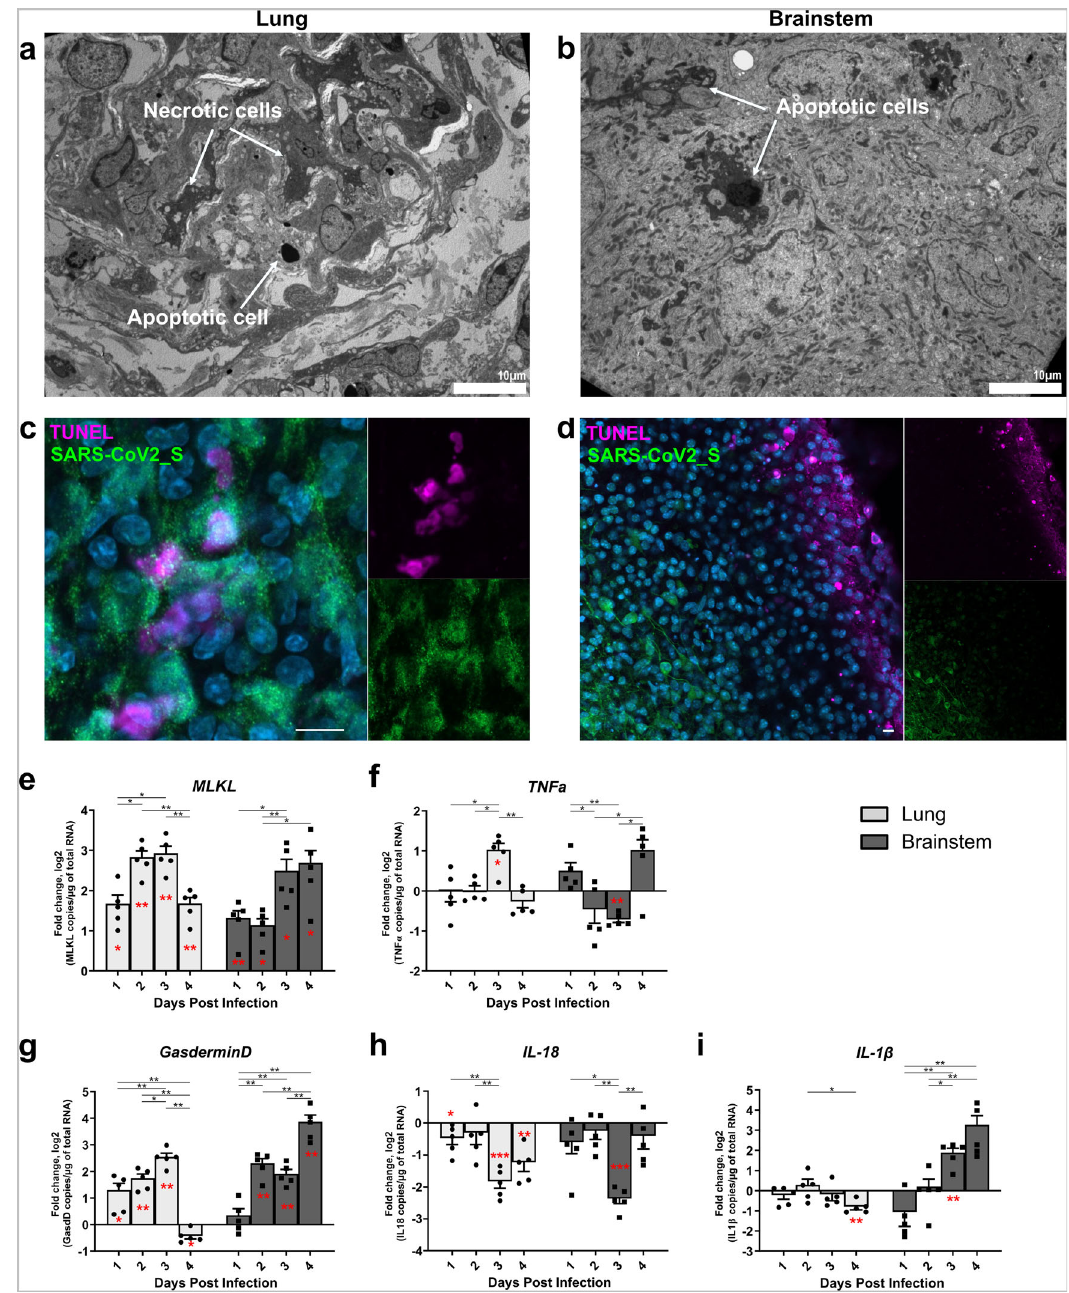
Fig. 6 Cell death in the ex vivo cultures. Hamster ex vivo cultures were infected with 1000 pfu of SARS-CoV-2 ( n = 5 biologically independent animals). a – c Lung and brainstem slices were fi xed at 1 day post infection (dpi) or 2 dpi, respectively. a , b Transmission electron microscopy analysis showing necrotic cells and apoptotic cells, scale bar is represented bottom right on each picture. c , d SARS-CoV-2_S protein immunostaining, and terminal deoxynucleotidyl transferase dUTP nick end labeling (TUNEL) labeling in the lung and brainstem. Nuclei were counterstained with DAPI. e – i mRNA expression level of e MLKL, f TNF- α , g Gasdermin D , h IL1 β , and i IL-18 over time. mRNA copies per µ g of total RNA were quanti fi ed by RT-qPCR and normalized to the variation of the amounts of GAPDH mRNA. Fold changes are relative to the number of copies of mRNAs in infected organotypic cultures compared to the uninfected ones. Error bars represent SD. Statistical analyses were performed using the Mann – Whitney test two-sided to compare the fold changes between days of culture (black stars). mRNA expression levels in infected samples were also compared with non-infected samples at the corresponding time point (red stars) using the one-sample T-test. * P < 0.05; ** P < 0.01; *** P < 0.001. Scale bar 10 µ m. Source data are provided as a Source Data fi